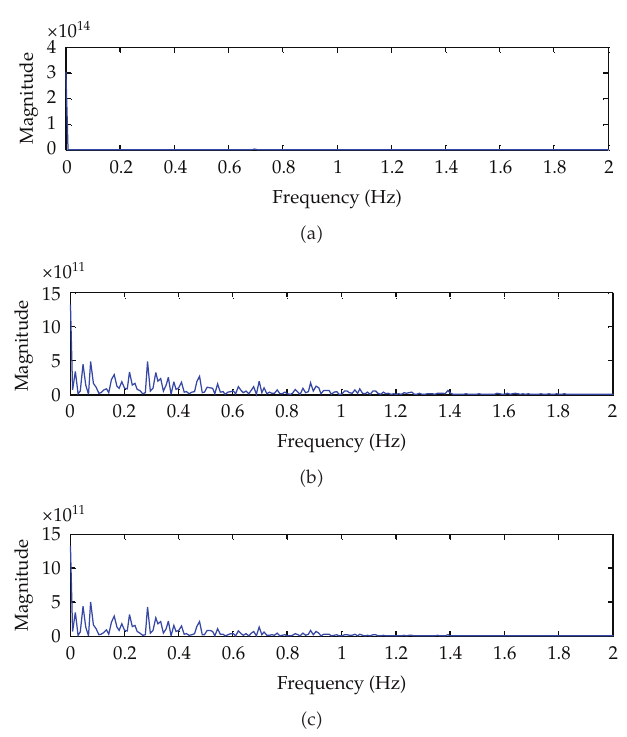
Figure 2: Power spectrum of the state variables x 1 (cid:2) t (cid:3) , x 2 (cid:2) t (cid:3) , and x 3 (cid:2) t (cid:3) of the PMSM system.